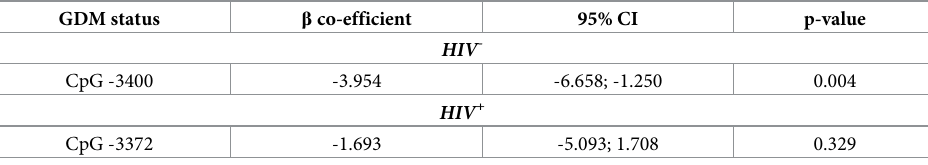
Table 2. Association between GDM and ADIPOQ DNA methylation levels in HIV - and HIV + women.